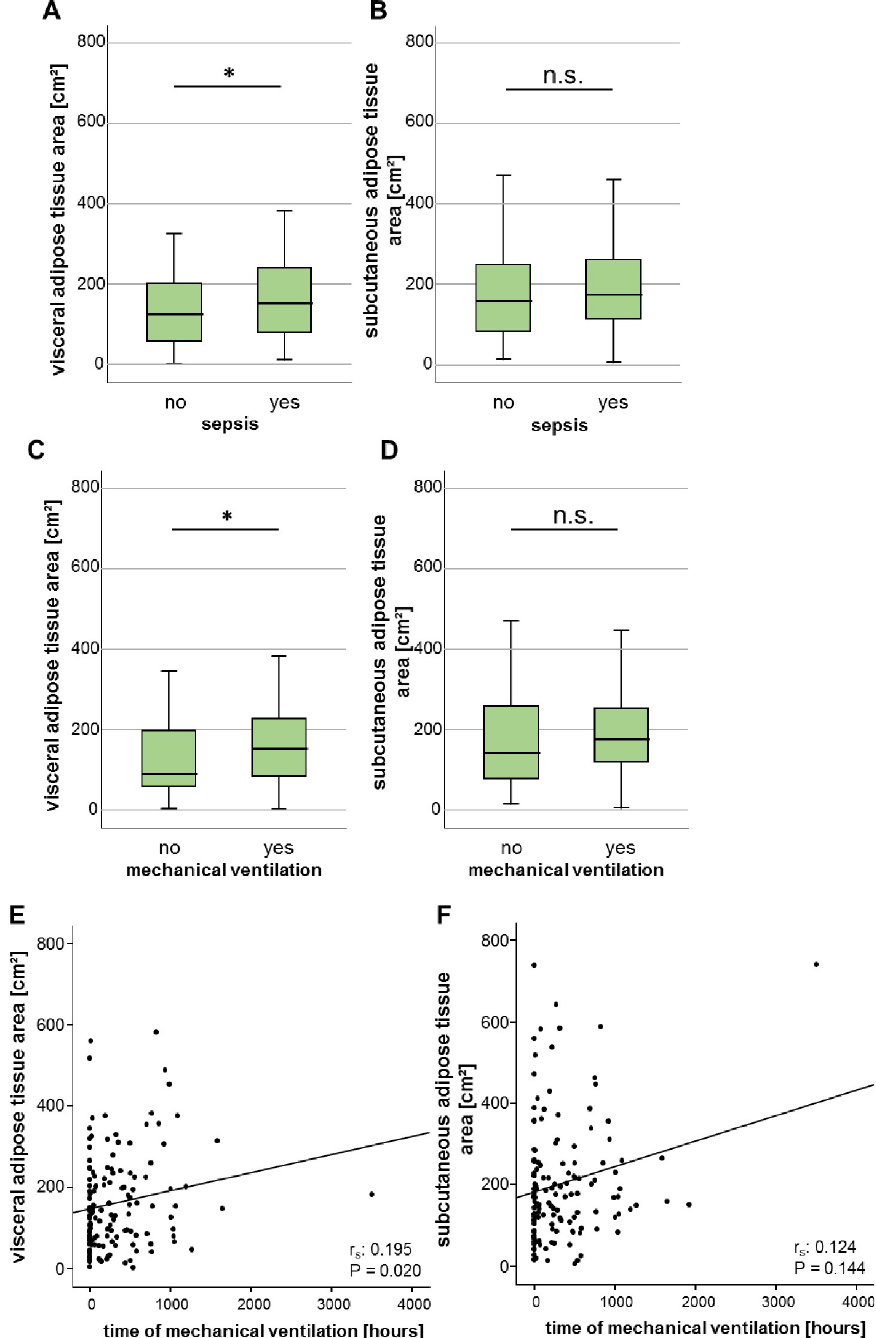
Fig 4. Augmented areas of the VAT are associated with increased duration of mechanical ventilation and prevalence of sepsis in critically ill patients. (A, B) Sepsis patients show an increased area of VAT but not SAT area compared to non-sepsis patients. (C, D) ICU patients requiring mechanical ventilation are characterized by a significantly increased area of the VAT but no difference of the SAT area. (E, F) There is a significant positive correlation between the VAT, but not the SAT and the duration of mechanical ventilation. Data are expressed as means ± SEM (A, B, E, F) or correlation analyses including Spearman´s rho coefficient (C, D); � p < 0.05.